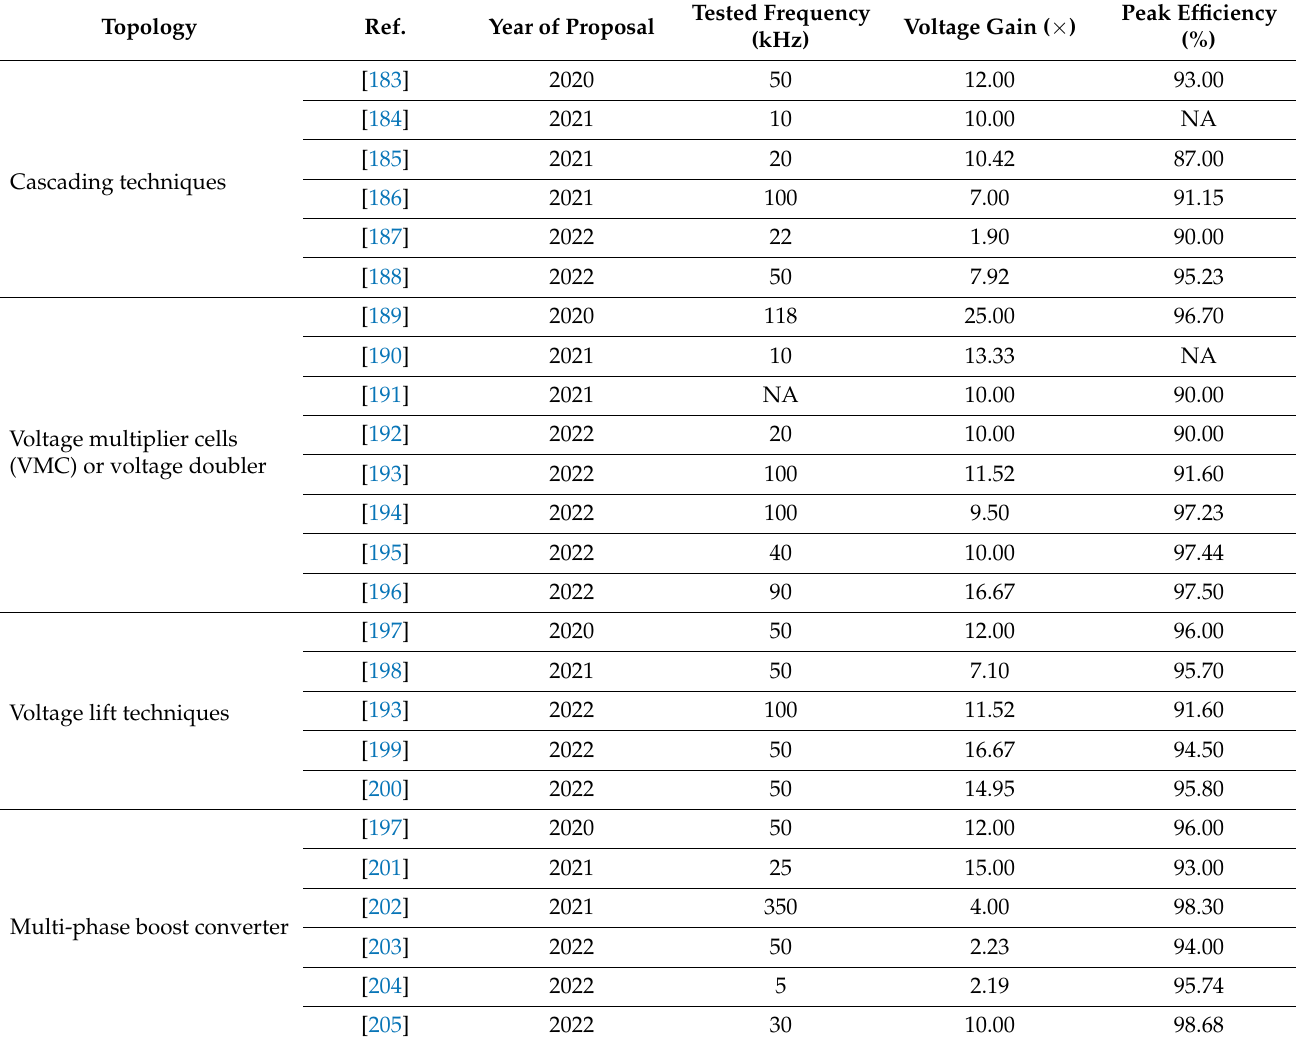
Table 10. Hierarchical evolution of various HGLP boost converter topologies